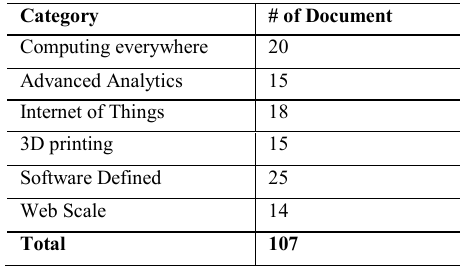
Table 1. The number of documents in each category.